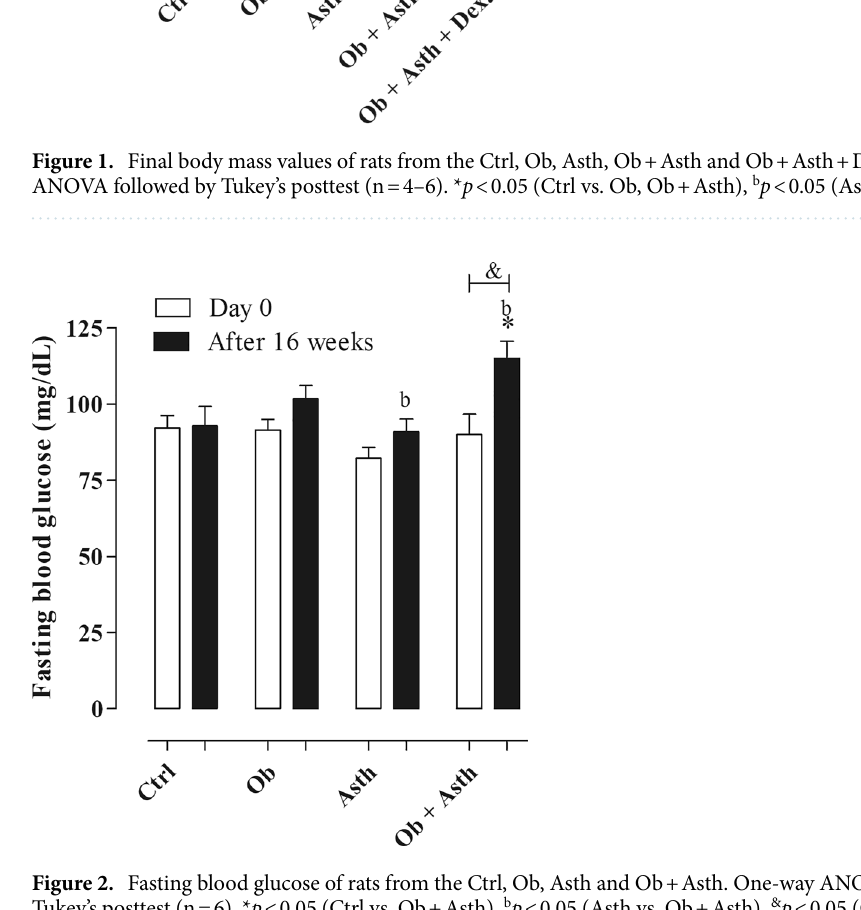
(Fig. 2, n = 6). After consuming the HGLI diet for 16 weeks, the Ob (101.7 ± 4.4 mg/dL) and Asth (90.8 ± 4.2 mg/dL) groups showed no change in blood glucose levels fasting compared to Ctrl (92.8 ± 6.3 mg/dL). However, the Ob + Asth (115.0 ± 5.6 mg/dL) showed an increase in fasting blood glucose levels when compared to the Ctrl, being higher than the blood glucose of the same animals before the dietary change